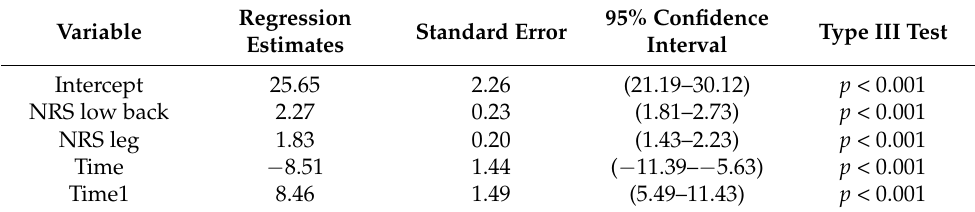
Table 3. Regression coefficient estimates and their 95% confidence intervals, based on the final model with multiple imputations.